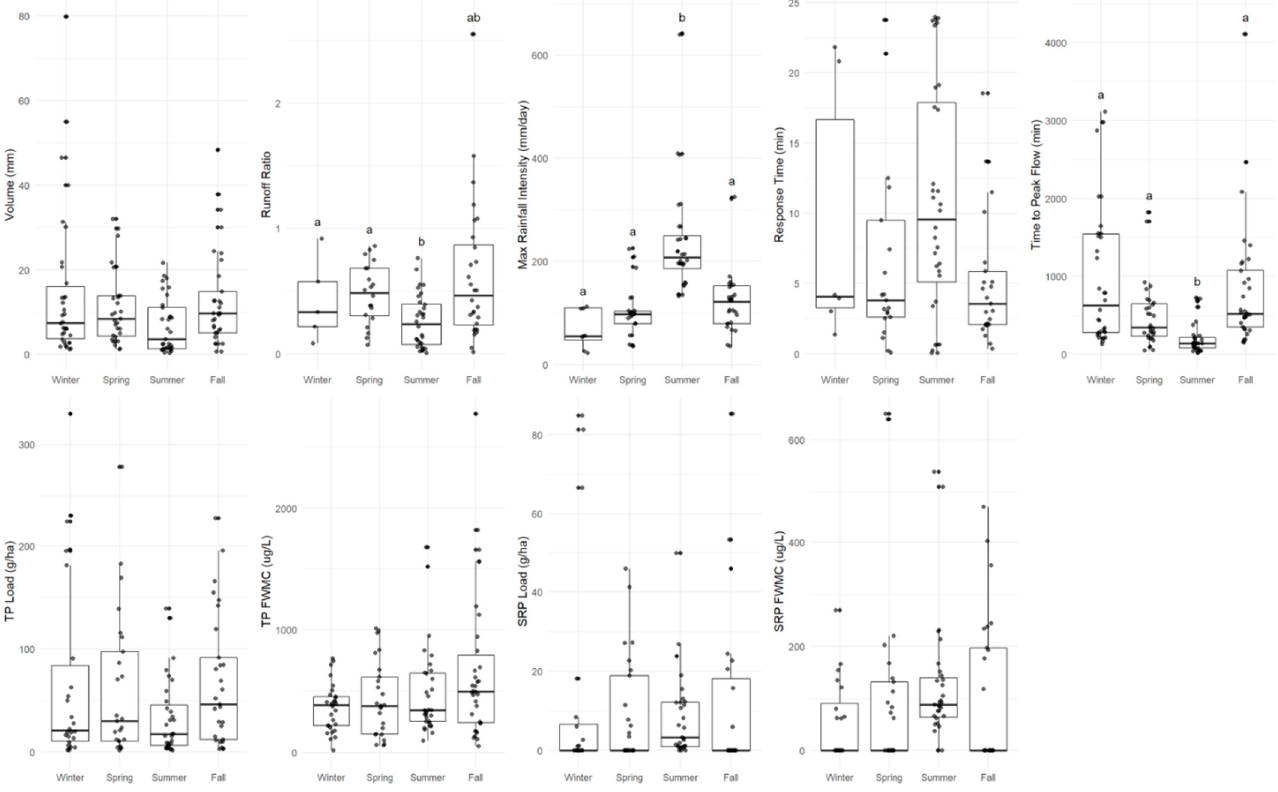
Figure 1. Boxplots of TD discharge and rainfall metrics for four hydrologic seasons (Fall: October– December, Winter: January–March, Spring: April–June, Summer: July–September). Letters denote significant differences between seasons. Jitter is used for plotting only and does not correspond to dates.